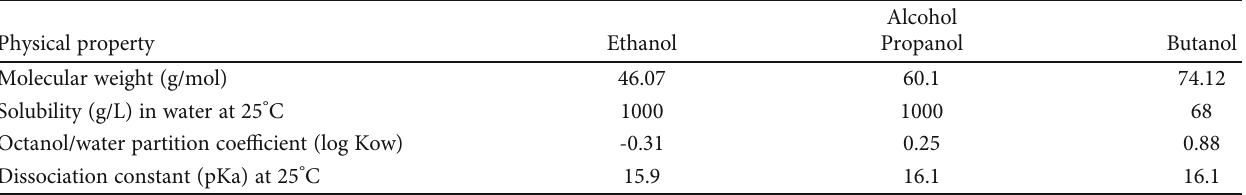
Table 2: Physical properties of the bioalcohols (PubChem) used in adsorption